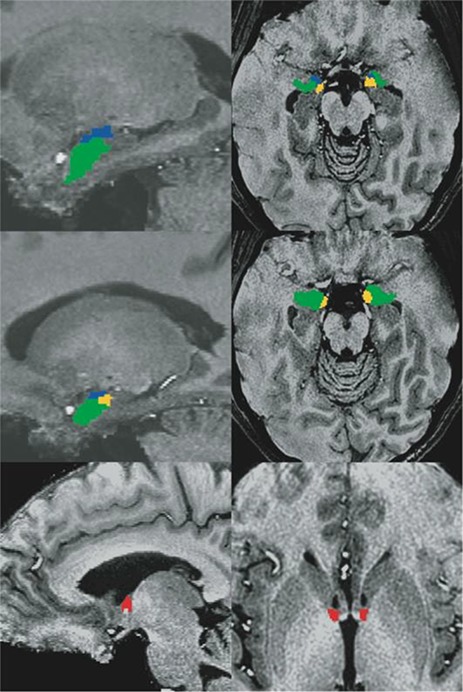
Example of individual BNST (red), CM (blue), superficial amygdala (yellow) and basolateral amygdala (green) ROIs in sagittal (left) and axial (right) views. BNST ROIs were drawn for each subject using anatomical landmarks described by Avery et al. (2014). Amygdala ROIs were Amunts et al.’s (2005) amygdala subregion maximum probability maps warped into each participant’s native space.